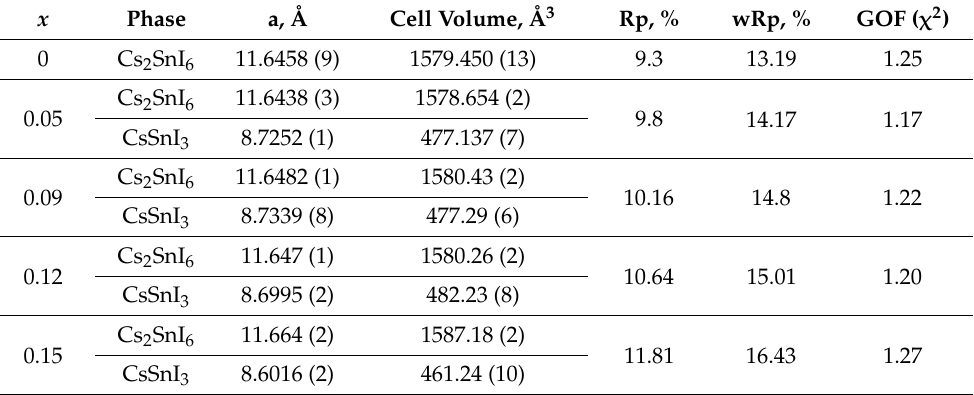
Table 2. Calculated cell parameters for the Cs 2 SnI 6 samples reduced by metallic gallium (RS series).